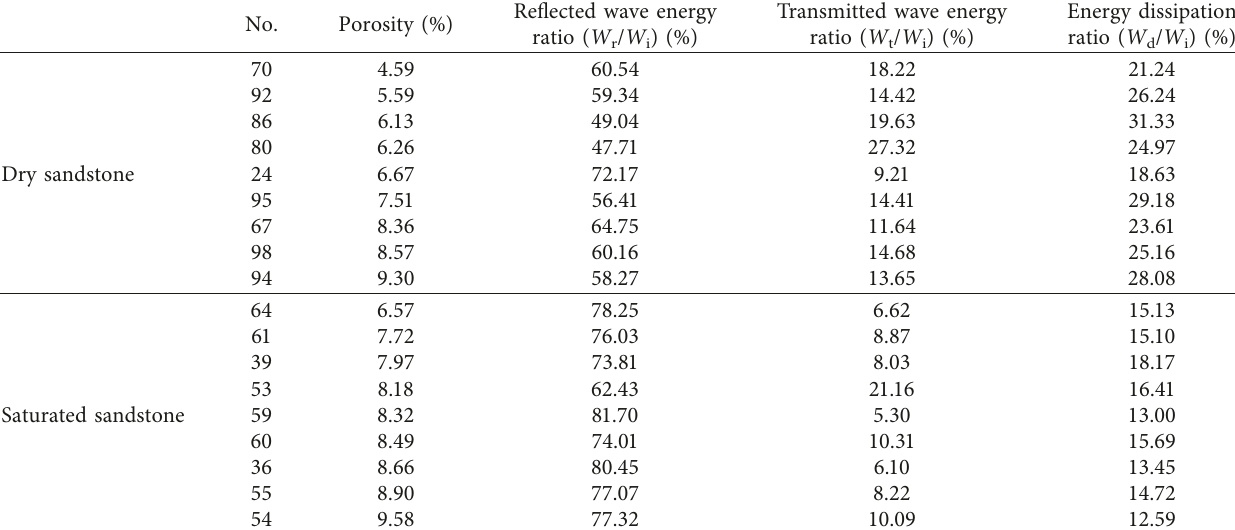
Table 2: Statistics on porosity and